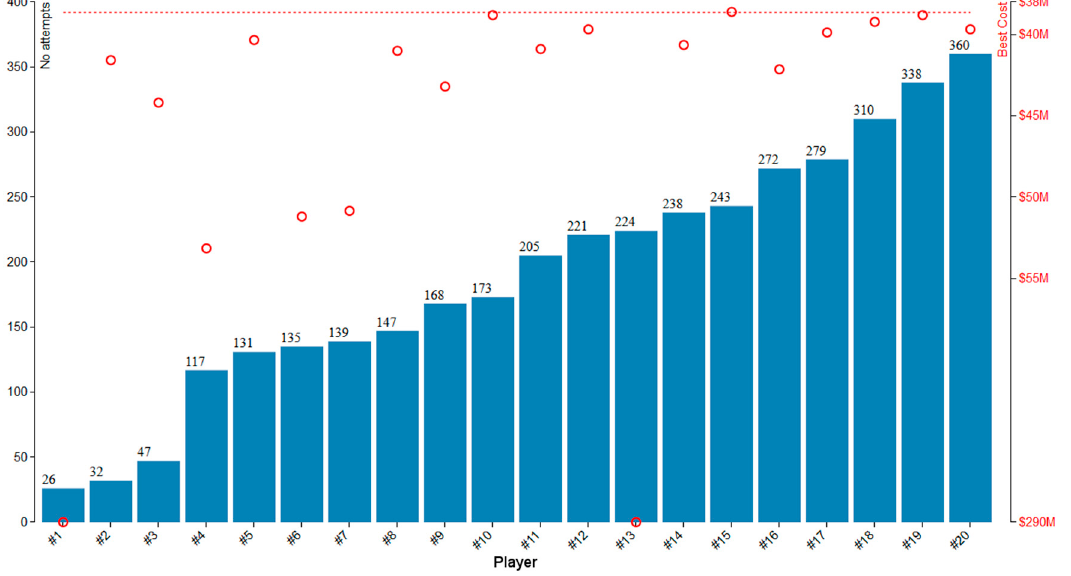
Figure 3. Number of changes made (bar chart) and the best cost attained (red circles) for each of the 20 players.